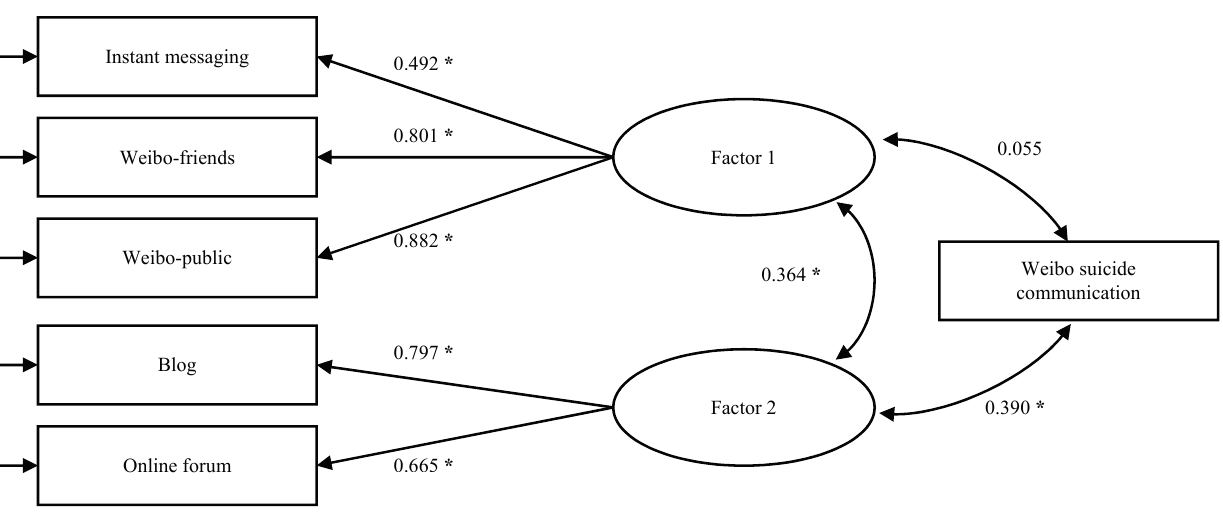
Figure 4. Association between latent constructs of five-item preference for using social media and Weibo suicide communication ( * p < 0.01).